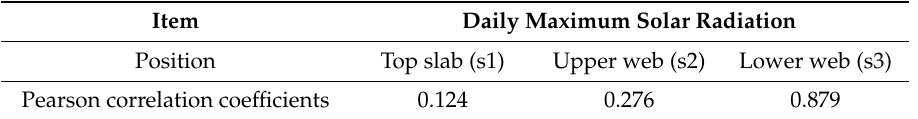
Table 1. Pearson correlation coefficients between daily maximum temperature gradient and daily maximum solar radiation. Item